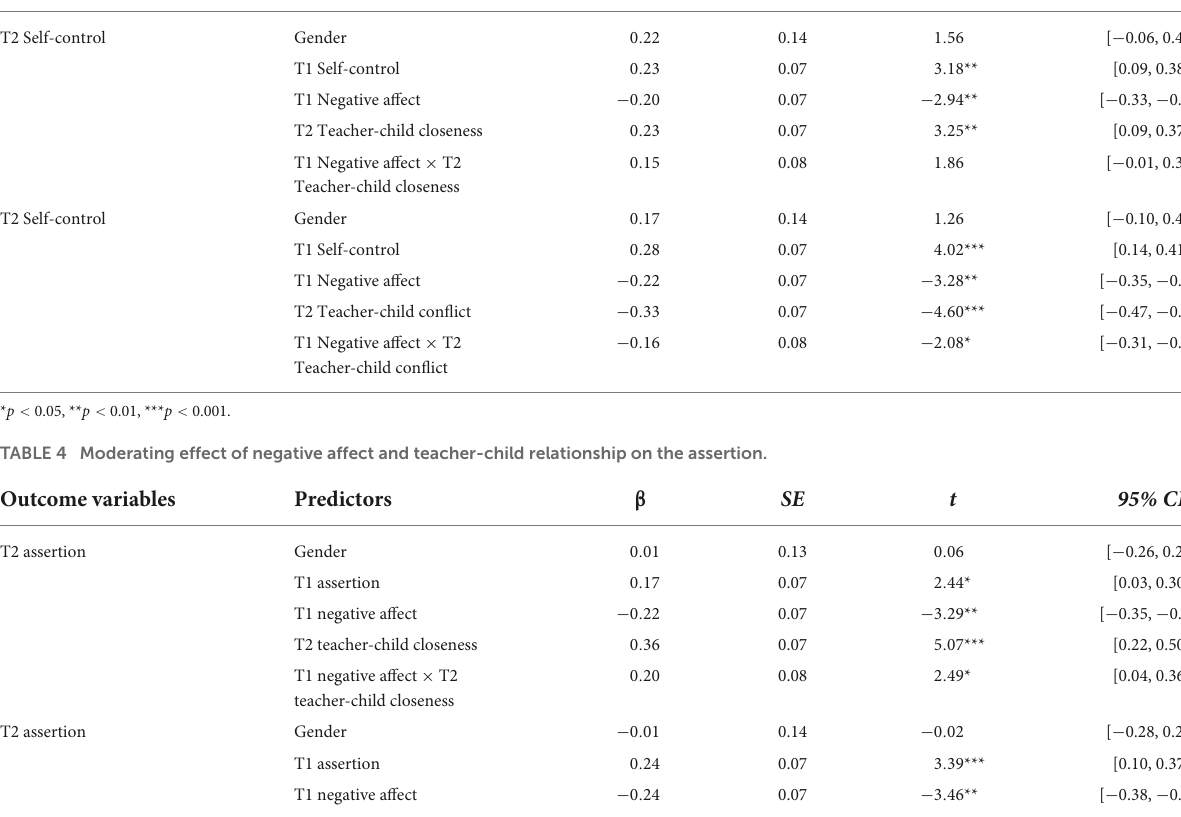
TABLE 3 Moderating effect of negative affect and teacher-child relationship on self-control. Outcome variables